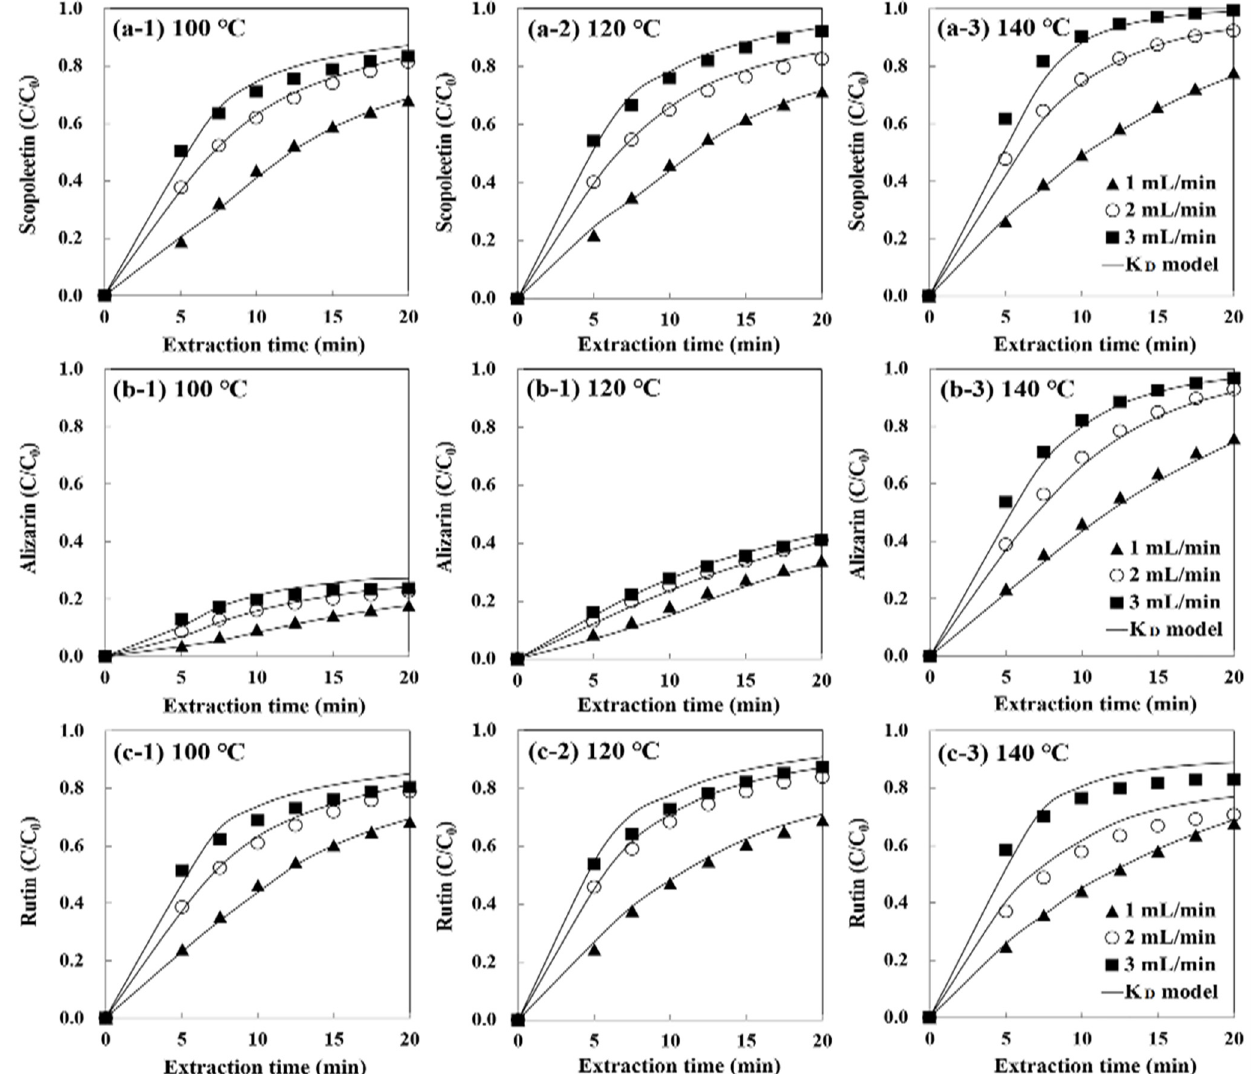
Figure 4. The thermodynamic partitioning model fit for the experimental data on subcritical water extraction of ( a ) scopoletin, ( b ) alizarin, and ( c ) rutin from noni fruits. The points represent the experimental values, and the solid lines are predicted in this model equation.